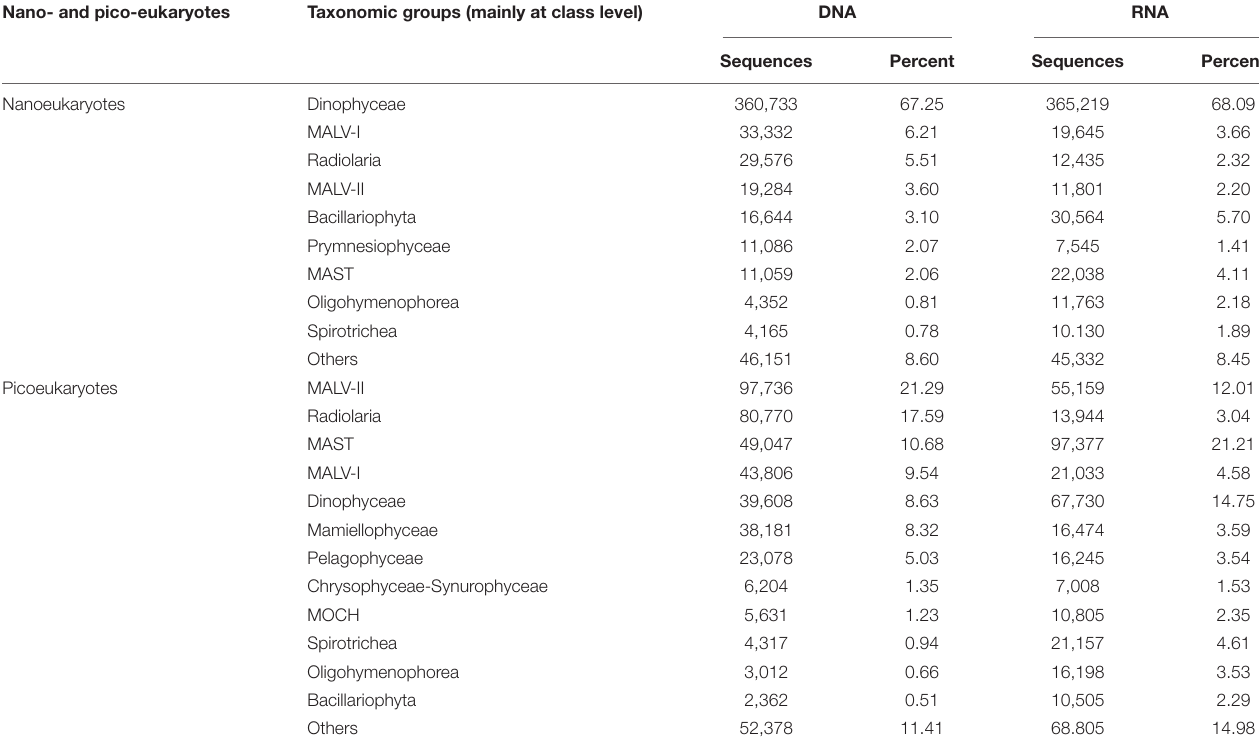
TABLE 1 | Nano- and pico-eukaryotic taxonomic groups (mainly at class level) sequences and percentages across samples based on the DNA and RNA surveys. Nano- and pico-eukaryotes Taxonomic groups (mainly at class level) DNA RNA Sequences